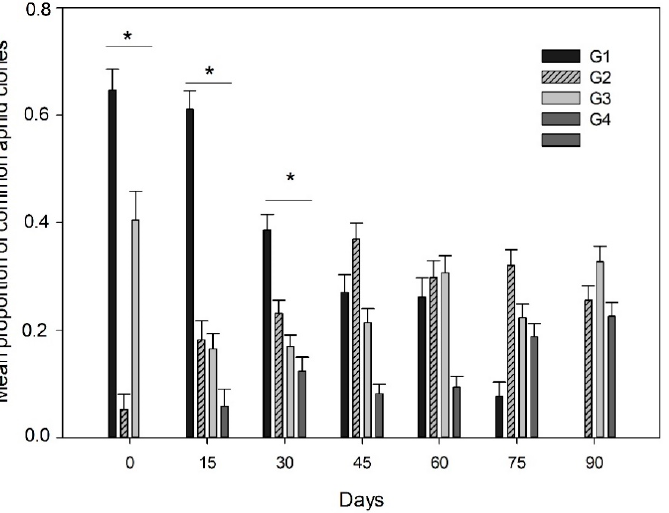
Figure 2. Predominance of common aphid clones across the season. Mean proportion ( ± SE) of the aphid clones G1, G2, G3 and G4 in the different sampling dates across one season. * Represents significant differences in the mean proportion of aphid clones in a sampling date.